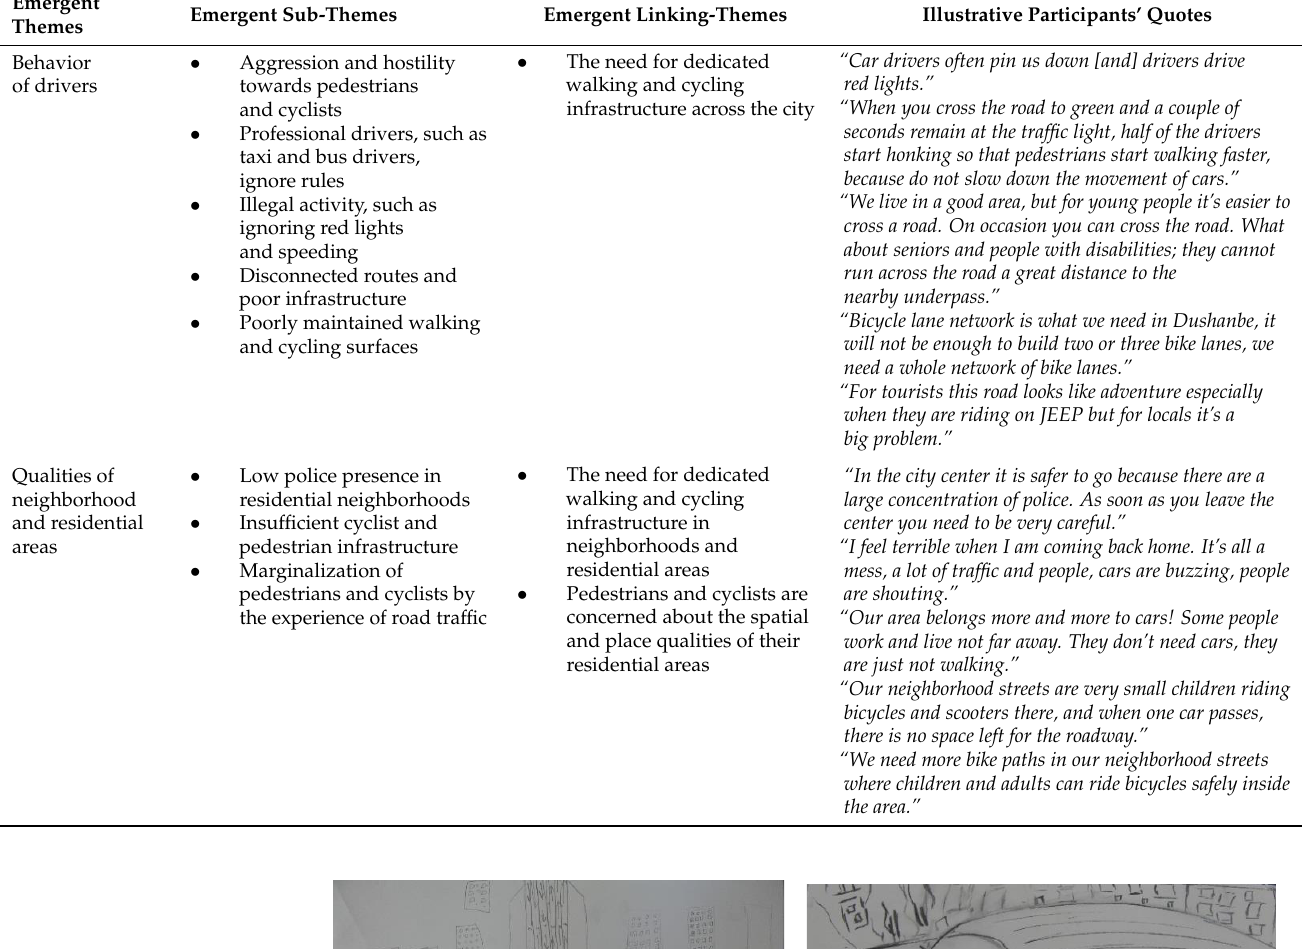
Table 2. Content Analysis of Stories and Experiences from 2021 and 2022 Workshops Combined.